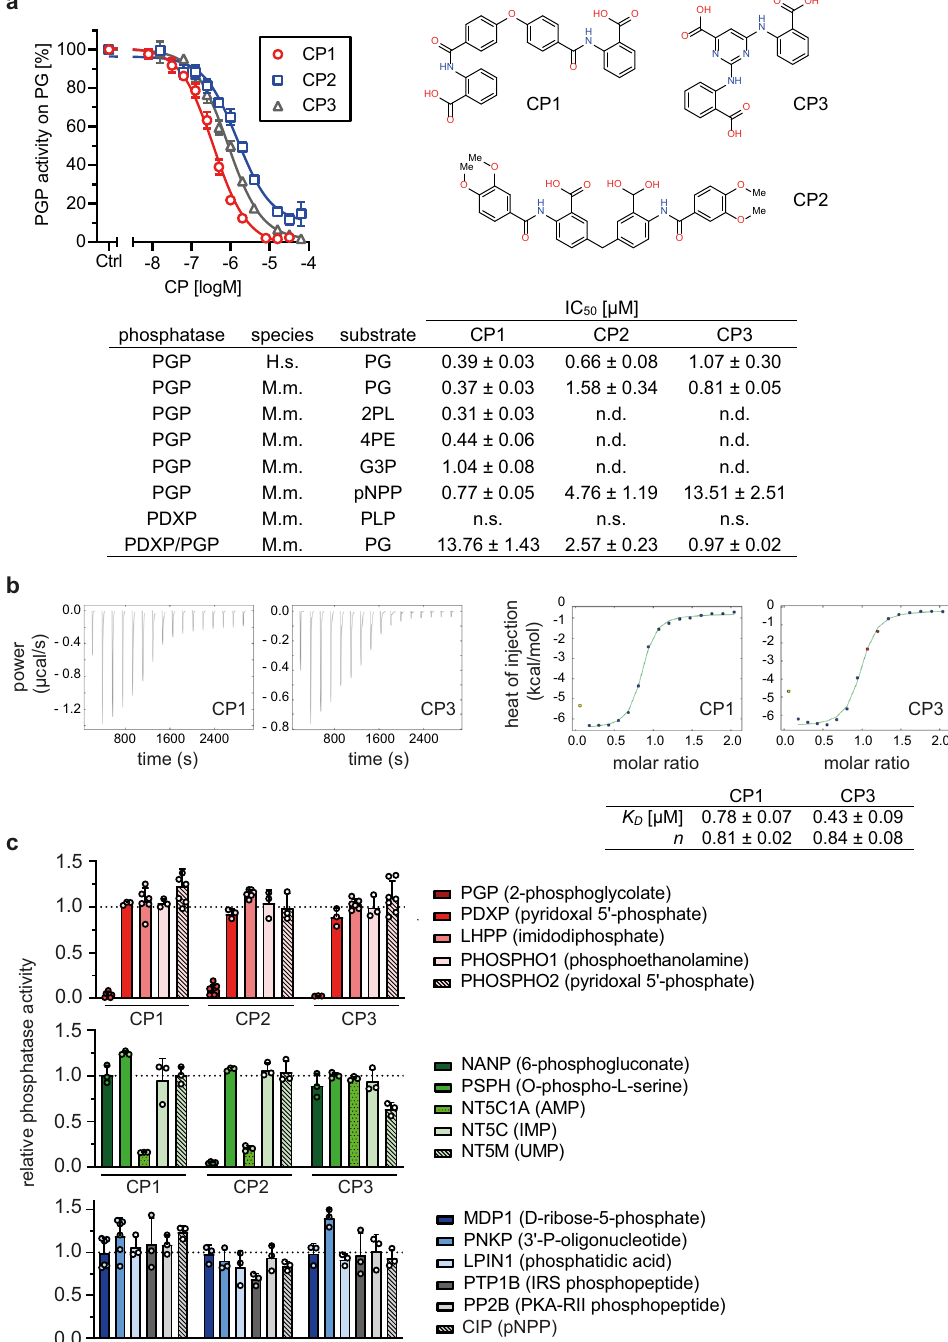
calorimetry measurements of the association reactions of CP1 or CP3 with murine PGP.Theleftpanelsshowrepresentativethermograms,therightpanelsshow fi tted binding curves of the isotherms. The binding data to PGP (mean values±S.E.M from n =3 independent experiments) are listed in the table. K D , dissociation con- stant; n , stoichiometry. c In vitroactivityassays withtheindicated phosphatasesin the presence of 40 µ M CP1, CP2 or CP3. Upper panel, C2-capped HAD phospha- tases; middle panel: C1-capped HAD phosphatases; lower panel: C0-capped HAD- and other phosphatases. The respective phosphatase substrates are given in the legend. Phosphatase activities in the presence of CP1-3 were normalized to the respective enzyme activities measured in the presence of the DMSO solvent con- trol. Data are mean values±S.E.M.; the number of n biologically independent experimentsisindicatedbythenumberofopensymbols.Sourcedataareavailable as Source Data